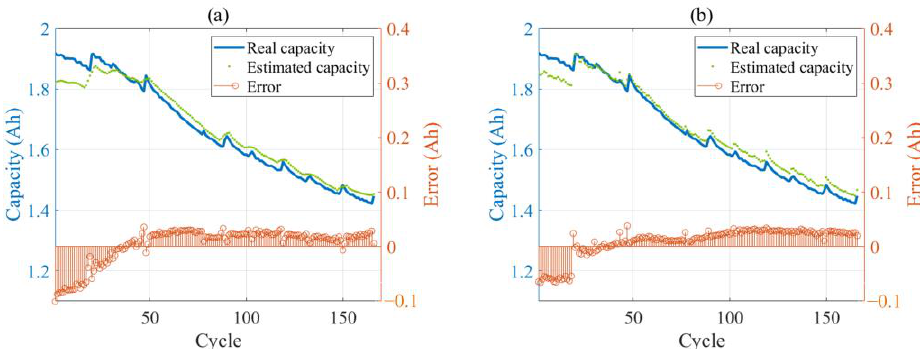
Figure 18. Capacity estimation results of NASA B7 3.92 – 4.01V: ( a ) Case 1; ( b ) Case 2.